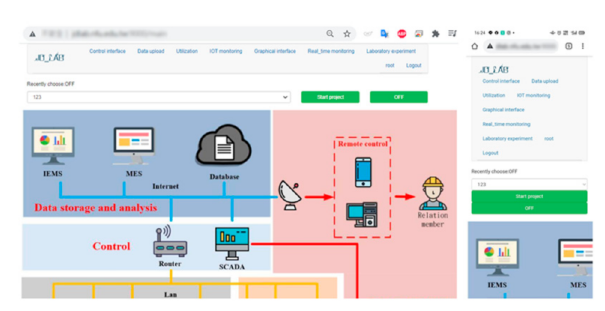
Figure 16. Project-control